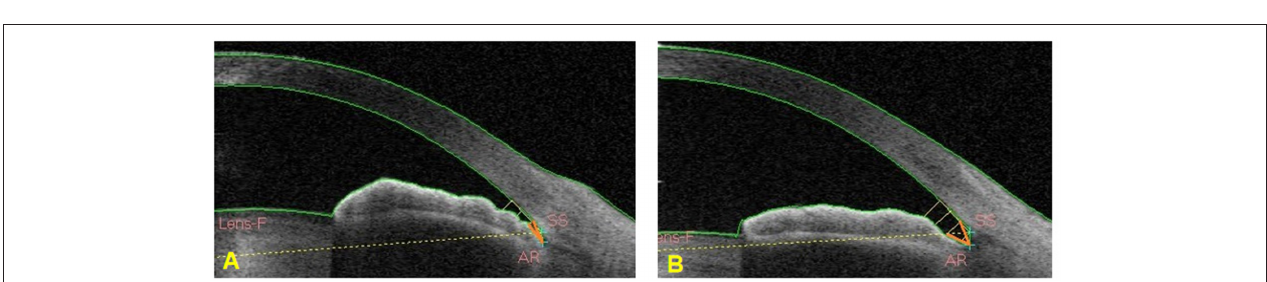
FIGURE 4 | TIA250 was marked by an orange angle. (A) The ACA image showed TIA250 between 11 and 15 degrees. (B) The ACA image showed TIA250 > 25